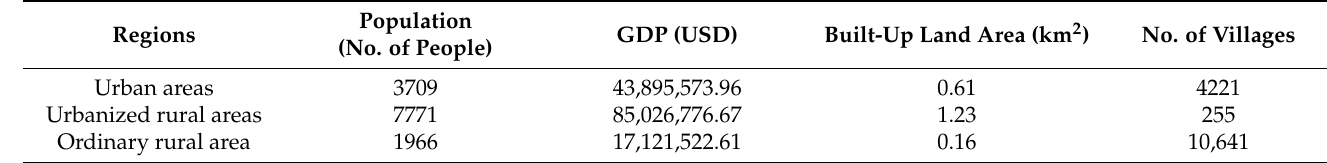
Table 2. Average values for population, GDP, and built-up land area in urban areas, urbanized rural areas, and ordinary rural areas in Fujian Province in 2015.